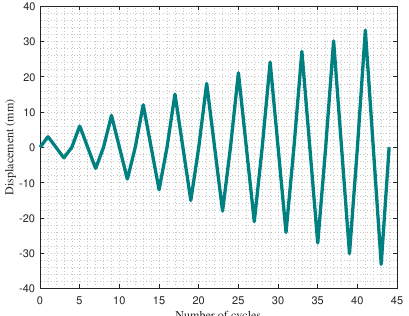
Figure 5. Cyclic loading protocol for the numerical model.